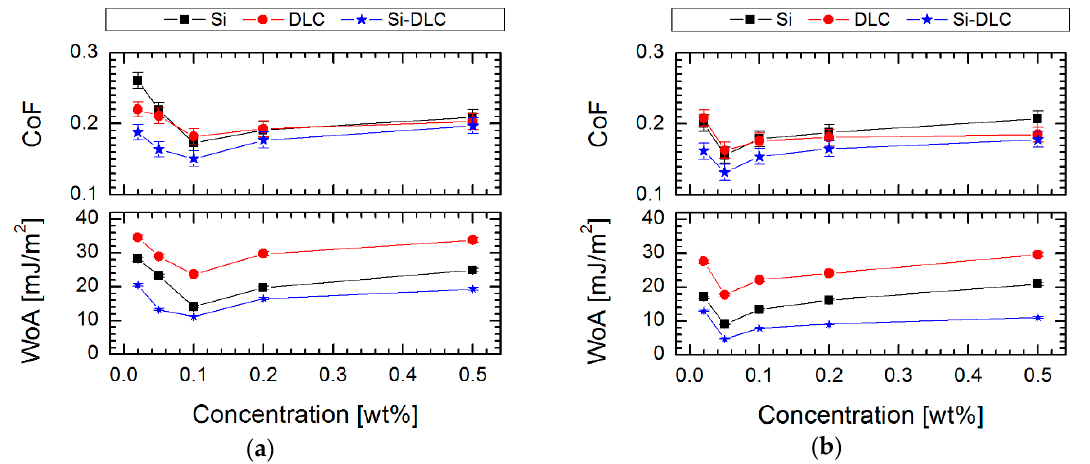
Figure 8. Coefficient of friction (CoF) and work of adhesion (WoA) of SAMs created using the LPD process on three surfaces with different contents of silicon as a function of the concentration of solutions of ( a ) FPTS and ( b ) FDTS compounds.